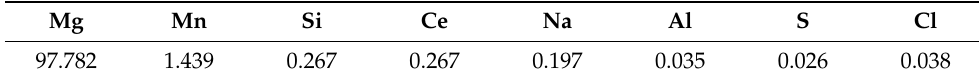
Table 1. MnE21 magnesium alloy chemical composition.